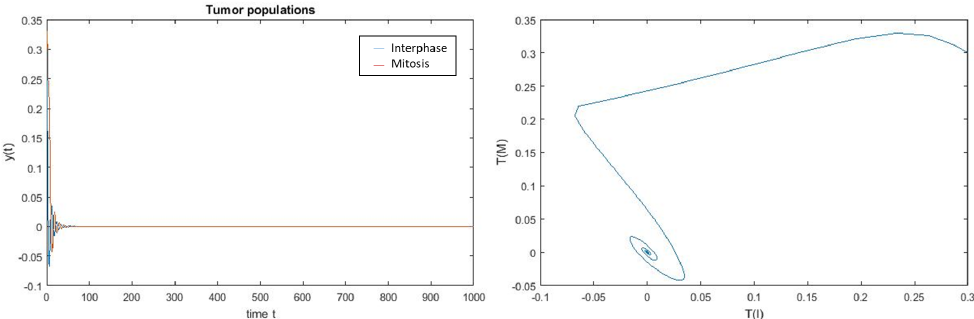
Figure 5. Tumour population with two immune response when τ = 5.6496 at E 0 = ( 0,0,15,0 ) .